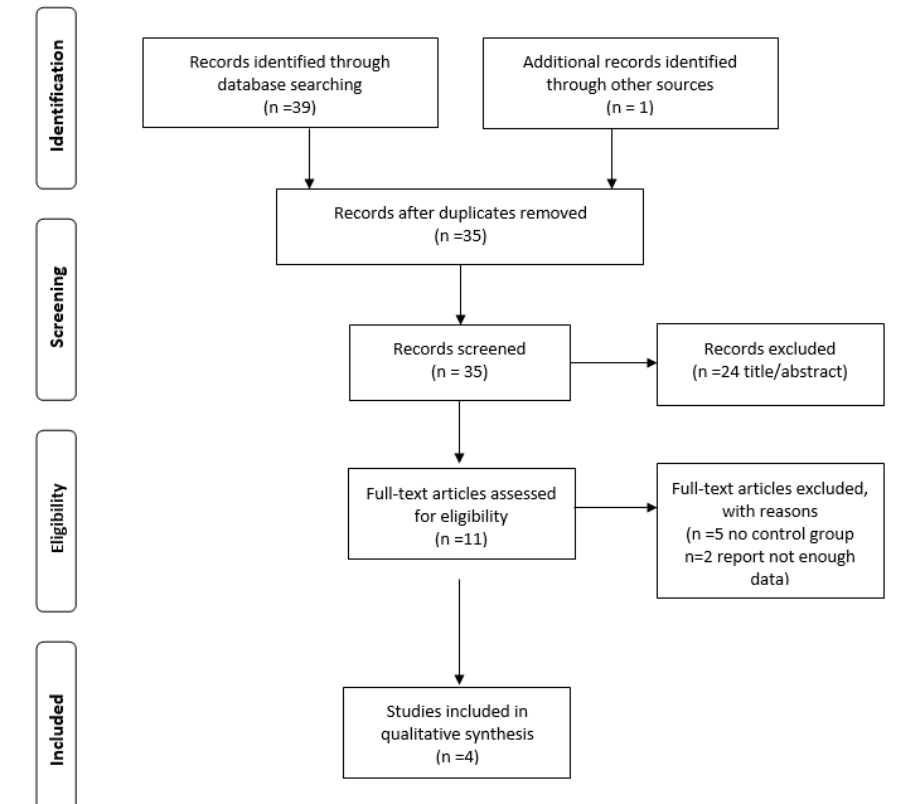
Figure 1. Flow chart of the databases searches on the influence of vaginal interventions on vaginitis and vaginal atrophy after brachytherapy or radiotherapy in patients with malignant endometrial or cervical tumors.